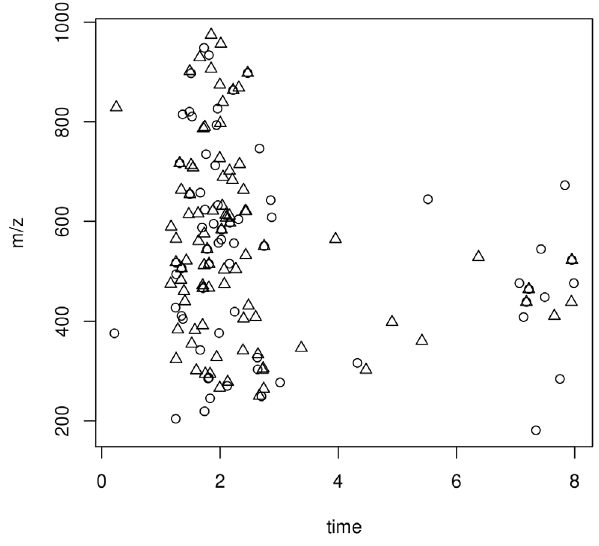
Figure 2. Features predictive of BOS. The median intensity of each feature is represented by the mass/charge (m/z) and retention time (time). Using a false discovery rate of 10%, the circles indicate features that are predictive of time to BOS 1 (triangles, n=89) and those that are predictive of time to BOS 2 or 3 (circles, n=66).